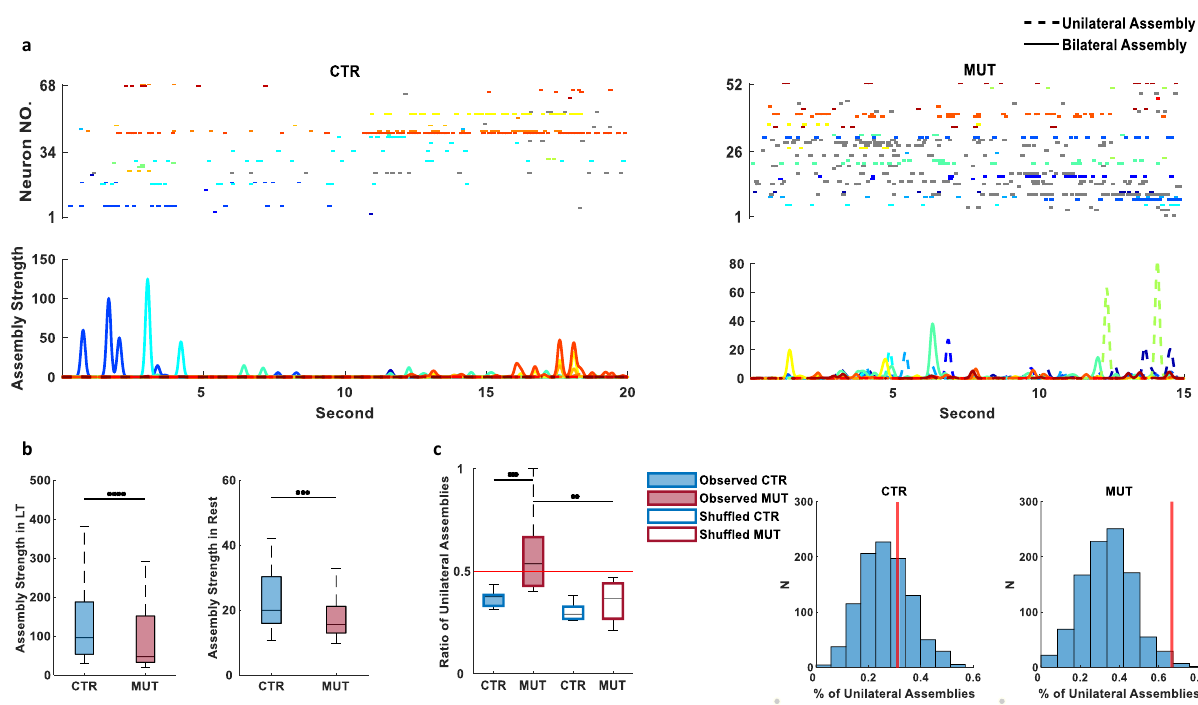
Fig. 2 Silencing CA3 input decrease bilateral CA1 cell assemblies. a Top: example raster plots of simultaneously recorded pyramidal cell activity during a single lap on the linear track from one control (68 cells) and one mutant (52 cells) mouse. Cells of the same color belong to the same assembly, cells shown in gray do not participate in any cell assemblies. Bottom: strength of each cell assemblies (colors correspond to rasters above; CTR, 16 assemblies in total; MUT, 12 assemblies in total); solid lines represent assemblies containing cells from bilateral CA1 (CTR, 10 assemblies; MUT, 6 assemblies); dashed line represents unilateral assemblies (CTR, 6 assemblies; MUT, 6 assemblies). b Strength of assembly activation on the linear track (LT) and during the subsequent rest session was signi fi cantly lower in mutants (In LT: CTR, N = 4 animals, n = 118 assemblies; MUT, N = 5 animals, n = 119 assemblies, P (LT) = 3 : 196 ´ 10 (cid:1) 7 ; In rest session: CTR, N = 4 animals, n = 114 assemblies; MUT, N = 5 animals, n = 114 assemblies, P (rest) = 1 : 75 ´ 10 (cid:1) 5 ). c Fewer bilateral cell assemblies in CA3-TeTX mice. Left: the fraction of unilateral assemblies was signi fi cantly higher in mutants (CTR, N = 4 animals, n = 8 (two directions for each mouse); MUT, N = 5 animals, n = 10 (two directions for each mouse); P = 0.0388, two-way ANOVA, followed by post hoc Bonferroni test, P (observed CTR vs . observed MUT) = 0.002, P (observed MUT vs. shuf fl ed MUT) = 8 : 112 ´ 10 (cid:1) 4 , P (observed CTR vs. shuf fl ed CTR) = 1). Right: examples from one control and one mutant animal demonstrate the relationship between the observed fraction of unilateral assemblies (red line) and population distribution of the shuf fl ed reconstituted assemblies. Unless mentioned, all signi fi cant difference in Fig. 2 were tested with two-sided Wilcoxon ’ s rank-sum